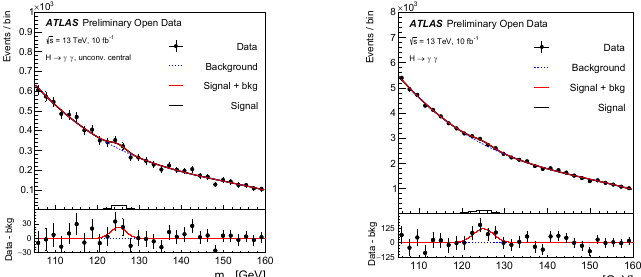
Figure 6. Diphoton invariant-mass spectrum as observed in the selected diphoton events, with (left) two unconverted photons and (right)